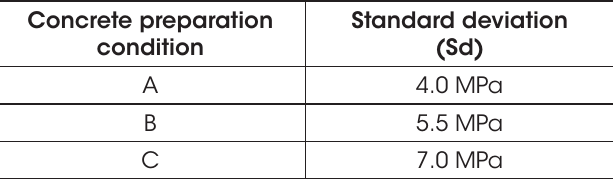
Table 1 Standard deviation to be used depending on the concrete preparation condition [20] Concrete preparation condition